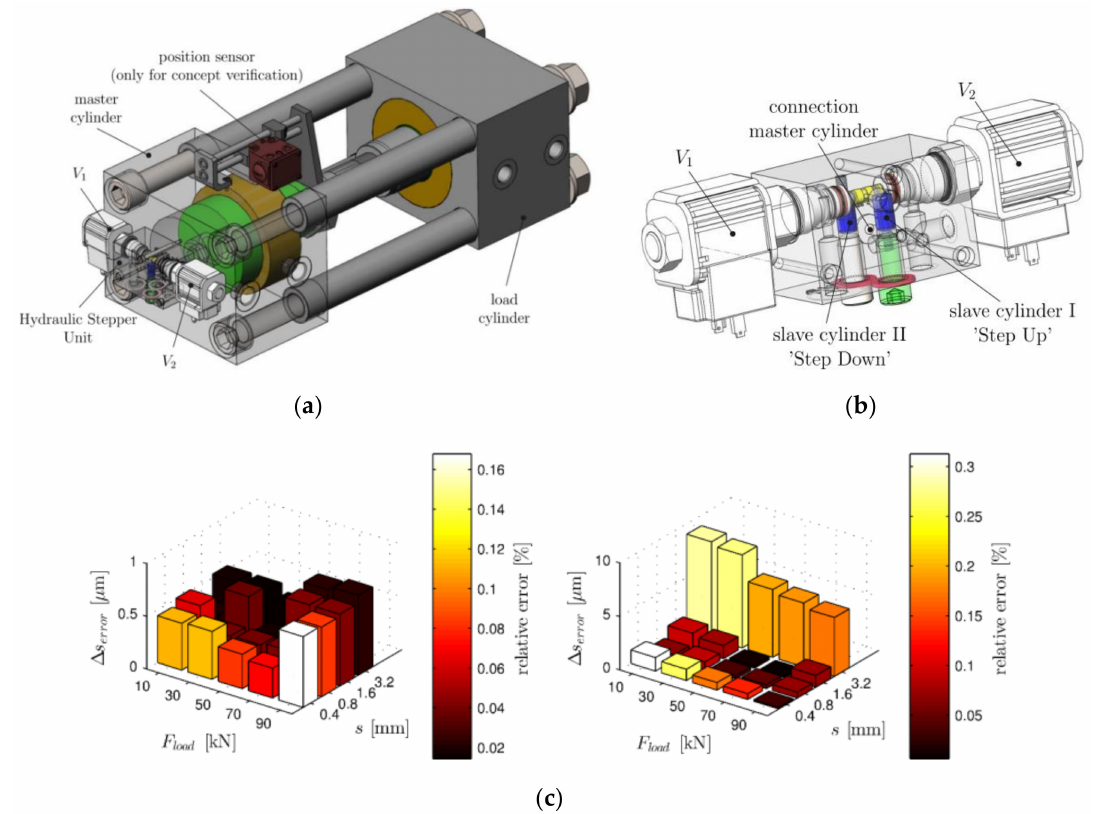
Figure 24. Hydraulic stepping actuator: ( a ) Mechanical design of the test rig; ( b ) Detail view of the Hydraulic Stepper Unit; ( c ) Position repeatability for various strokes and load forces ( left ); position accuracy of the sensorless control ( right